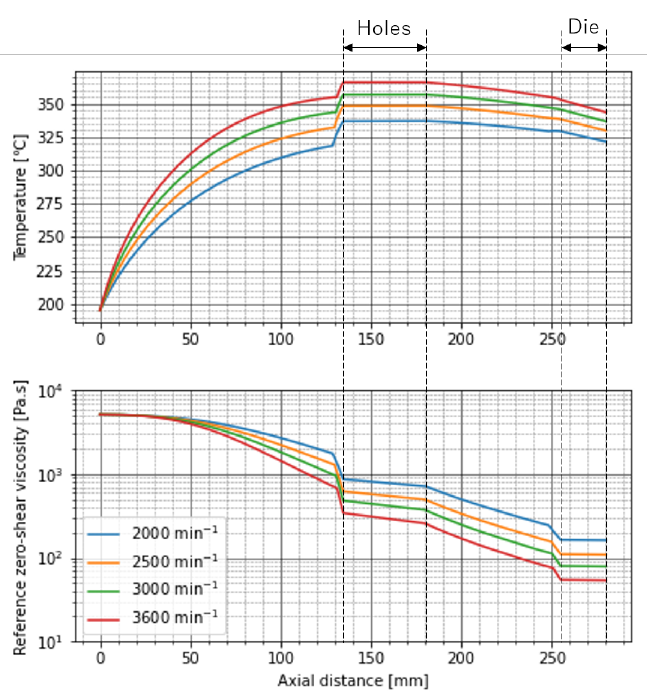
Figure 13. Predictions of temperature distribution and distribution of reference zero-shear viscosity in experiment